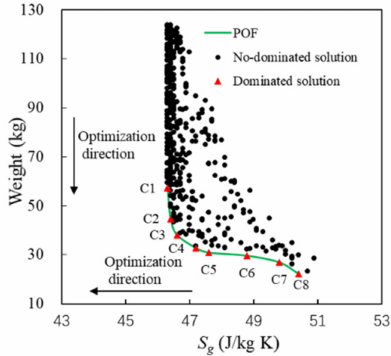
Figure 12. Component-level optimization